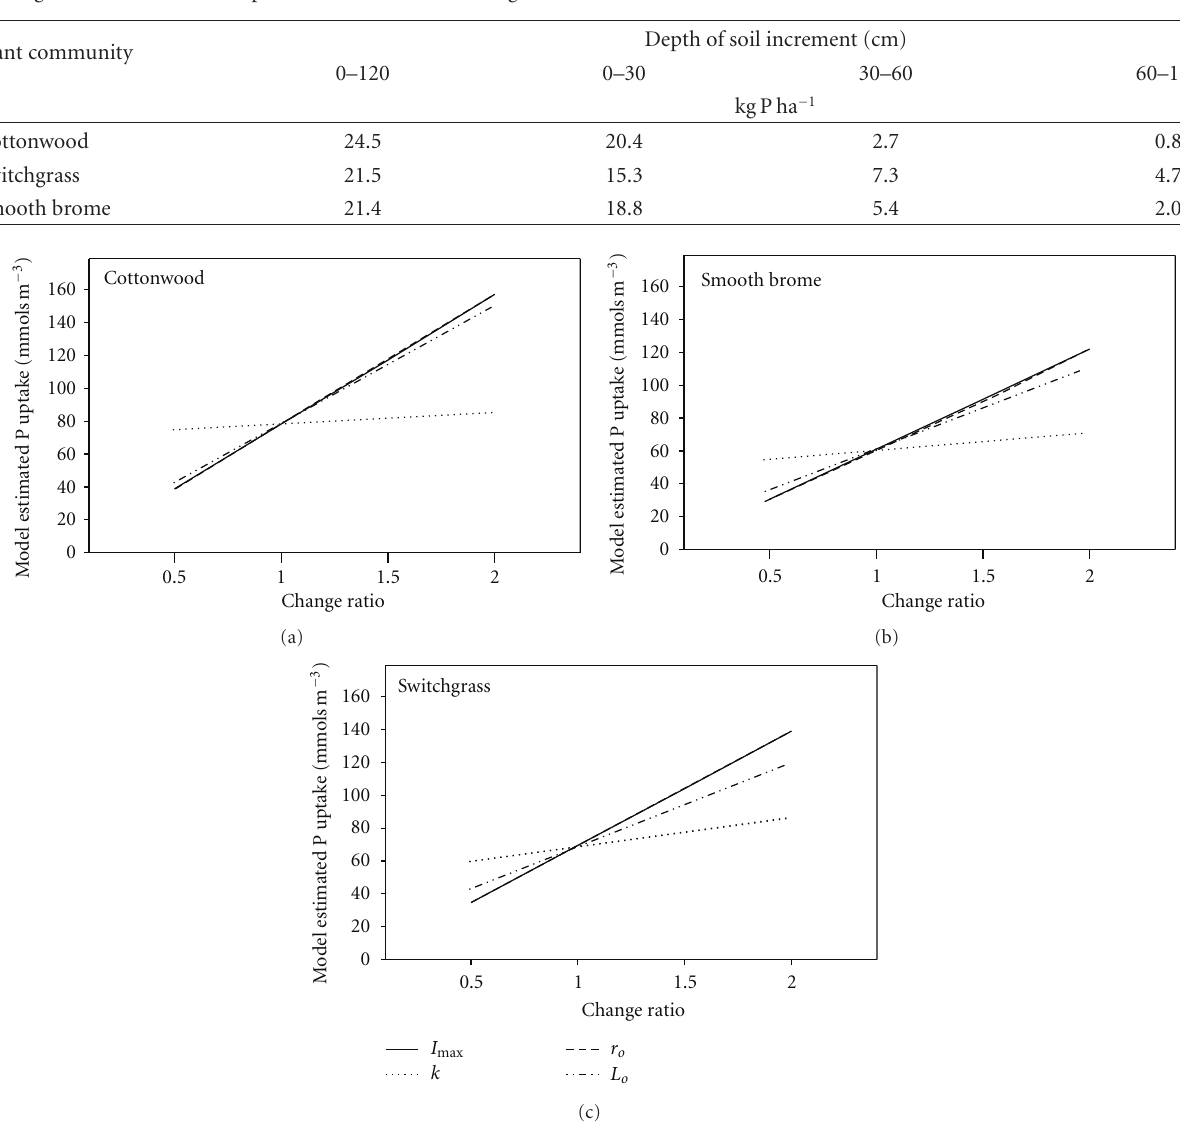
Figure 1: Sensitivity analysis of predicted P uptake by cottonwood, smooth brome, and switchgrass using the NST 3.0 model showing the e ff ect on predicted P uptake of varying individually the maximum nutrient influx rate at high concentration ( I max ), root growth rate ( k ), root radius ( r o ), and initial root length ( L o ) values while holding all remaining model parameters constant. Each parameter has been varied from a 50% reduction (0.5 change ratio) to a doubling (2.0 change